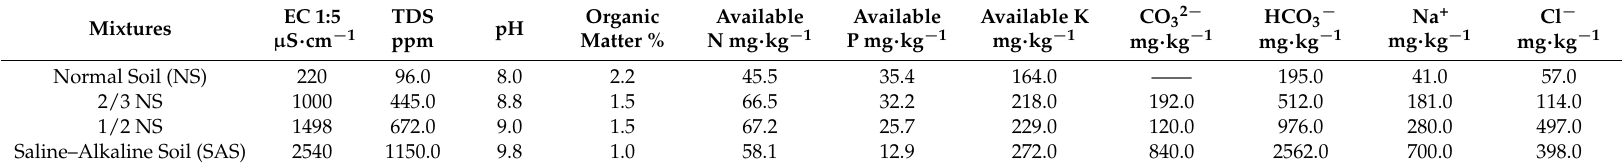
Table 1. Physical, chemical, and fertility characteristics of the three mixture types used in this